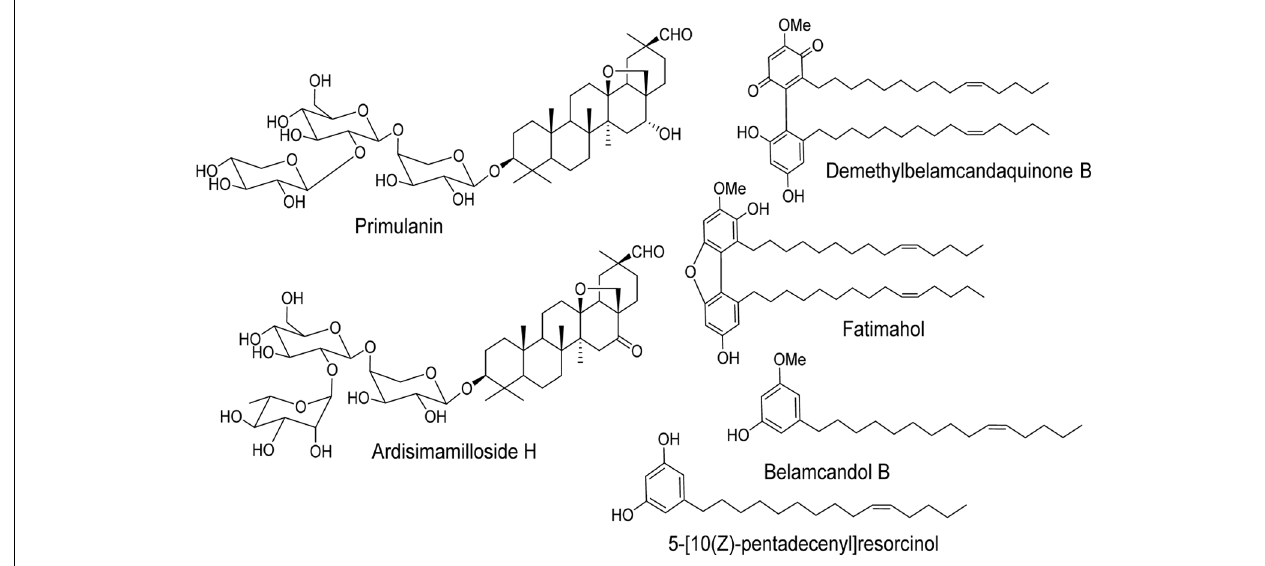
FIGURE 1 | Chemical structures of two saponins and four alkyl phenols isolated from the roots of Labisia pumila